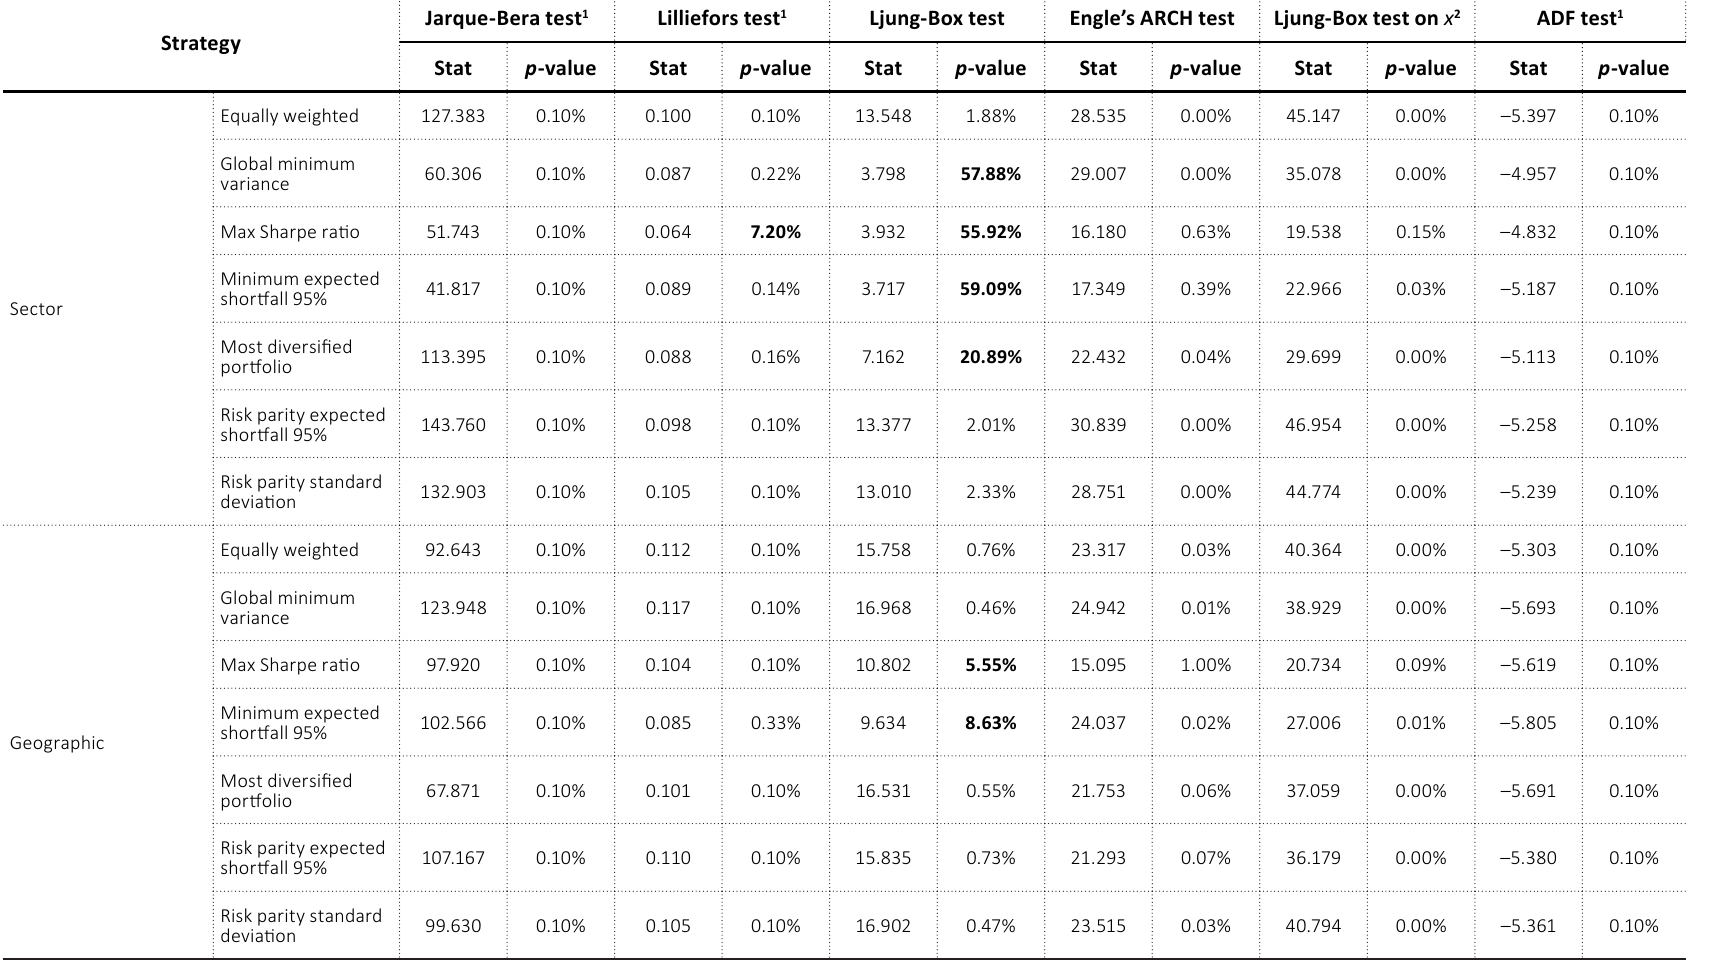
Table 7. Tests of deviations from normality for portfolios’ excess returns